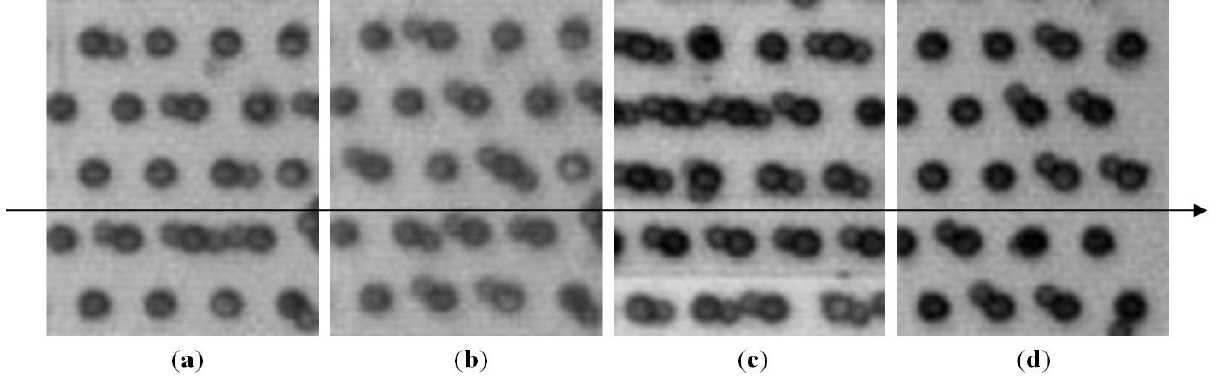
Figure 7. Images of microbead circling around static discs in rotating magnetic field. The alignment of the magnetic field lines is represented by the arrow through the images. The magnetic field rotational speed and magnetic field strength felt at the chip is given beneath the images. These were the two experimental parameters varied for the experiments.